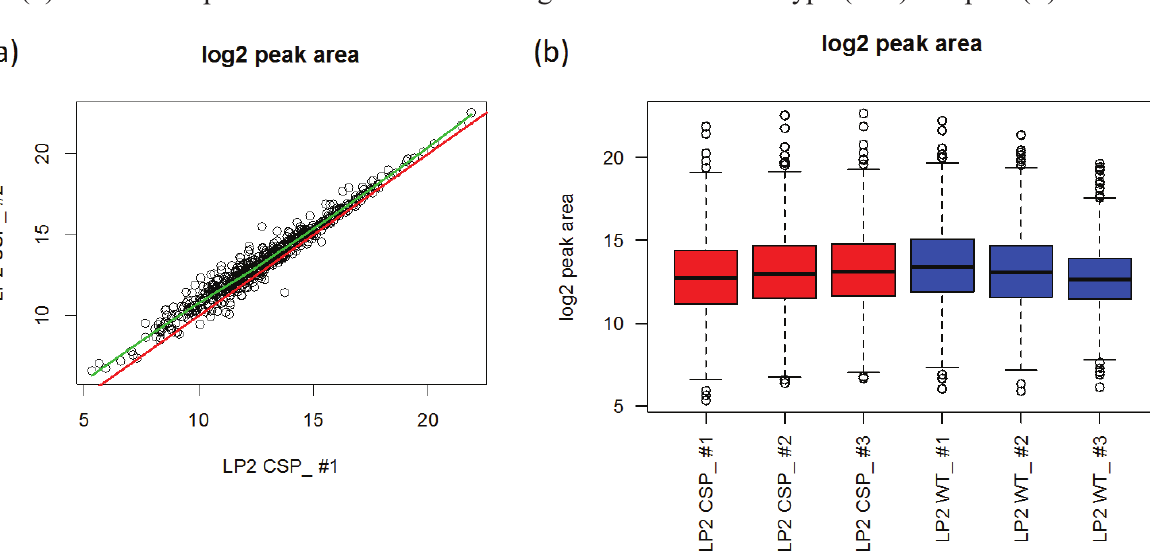
Figure 7. Comparison between two technical replicates from CSP knockout (KO) sample ( a ) and overall peak area distribution among CSP KO and wild type (WT) samples ( b